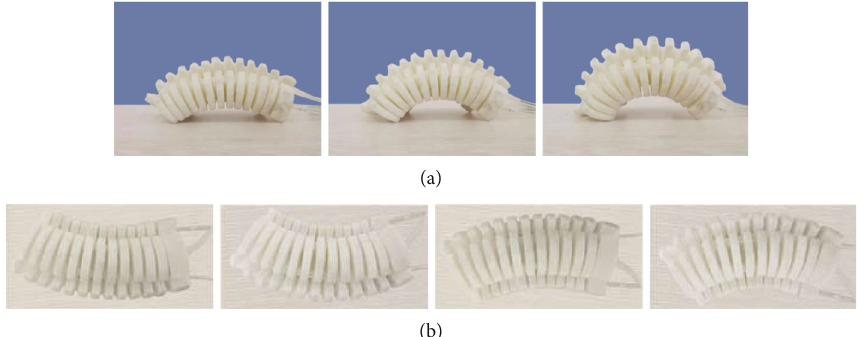
Figure 11: Motion process of pneumatic soft-bodied bionic actuator. (a) Middle part bending motion of actuator. (b) Left and right side bending motion of actuator.